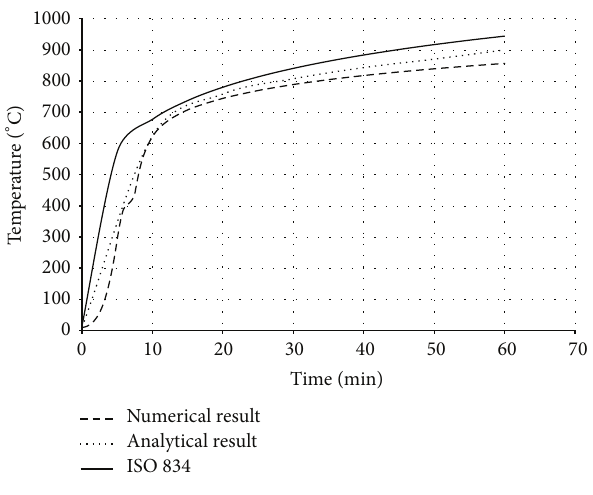
Figure 9: Comparison of 𝑇 - 𝑡 Curves at point 2.